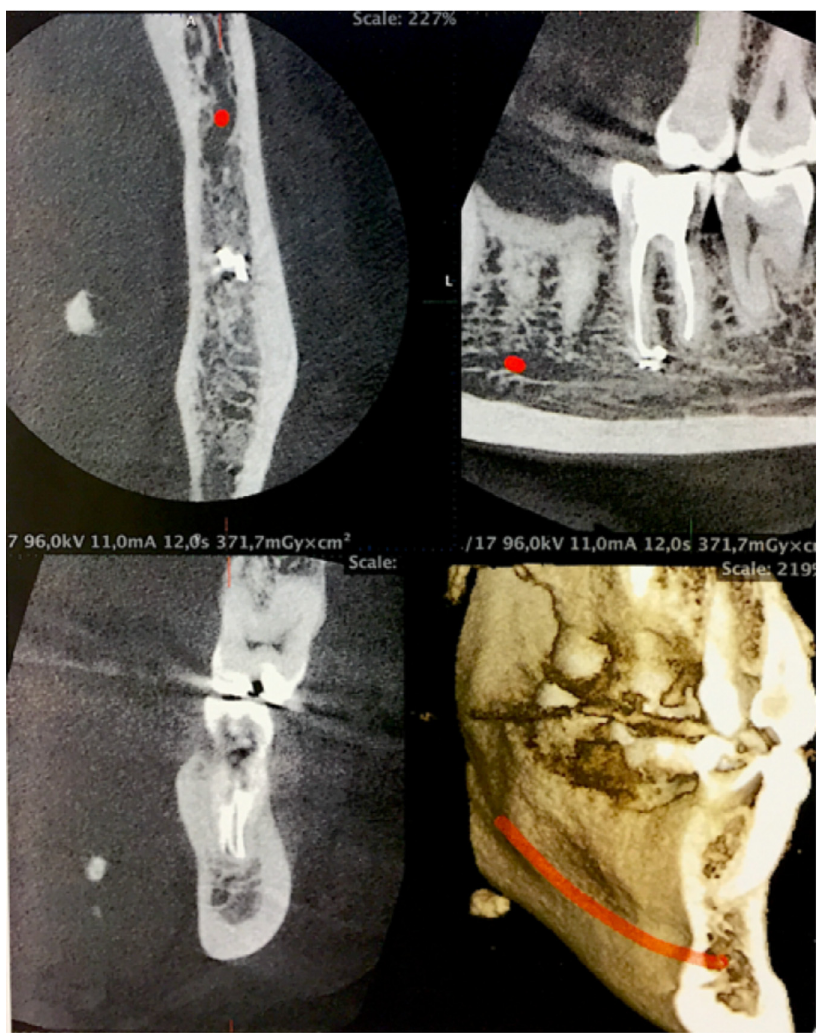
Fig. 10. Example a cone beam computed tomography showing a left submandibular